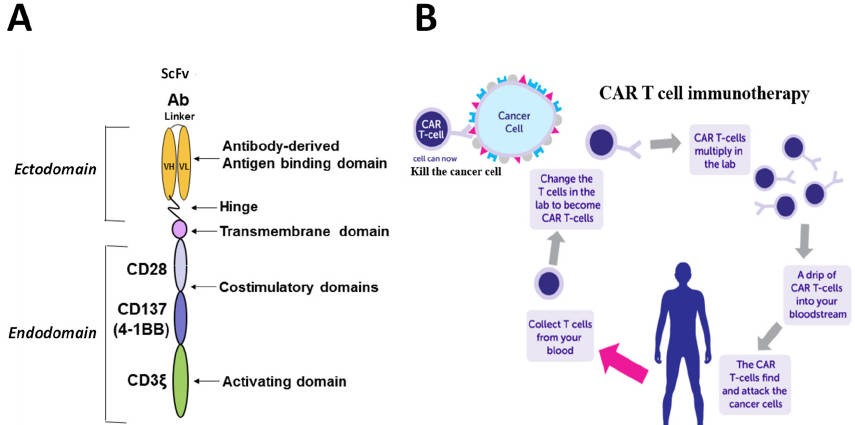
Figure 2. ( A ) CAR T structure. The fi gure from [11]. ( B ) Scheme of CART cell